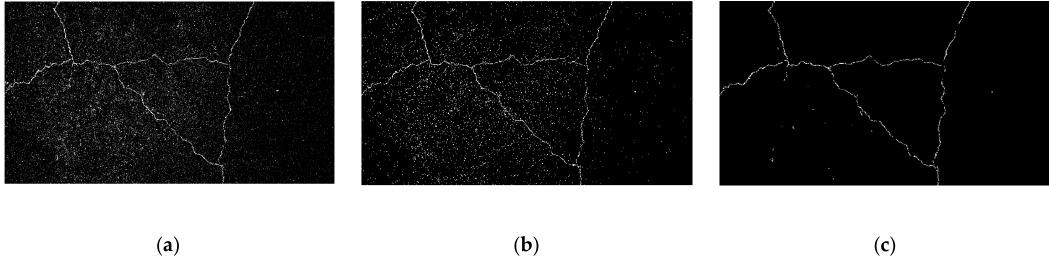
Figure 6 . ( a ) Enhanced edge, ( b ) first-level binary, and ( c ) second-level binary images; defected dataset, spatial domain, and Sobel filter.